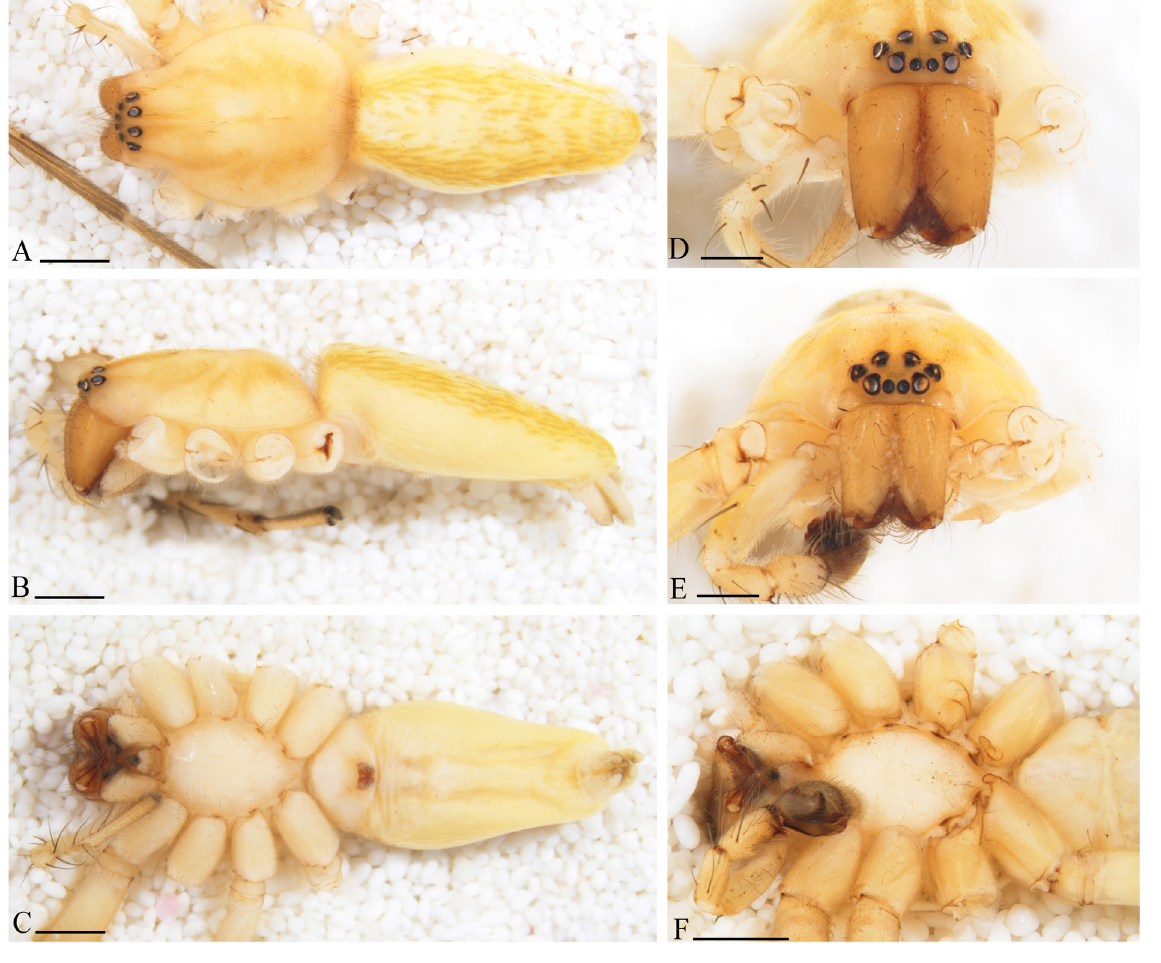
Fig. 31. Anyphaena miniducta sp. nov. A–D . Paratype, ♀ (CNAN-T01560). E–F . Allotype, ♂ (CNAN-T01515). A . Dorsal habitus. B . Lateral habitus. C . Ventral habitus. D . Prosoma, anterior view. E . Prosoma, anterior view. F . Prosoma, oblique view. Scale bars: A–C = 1.0 mm; D–F = 0.5